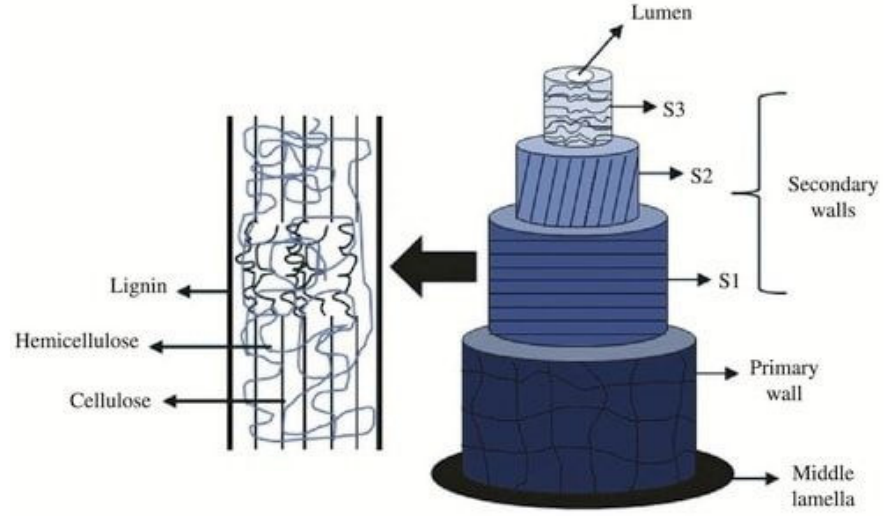
Figure 1. Structure of plant fiber [48].